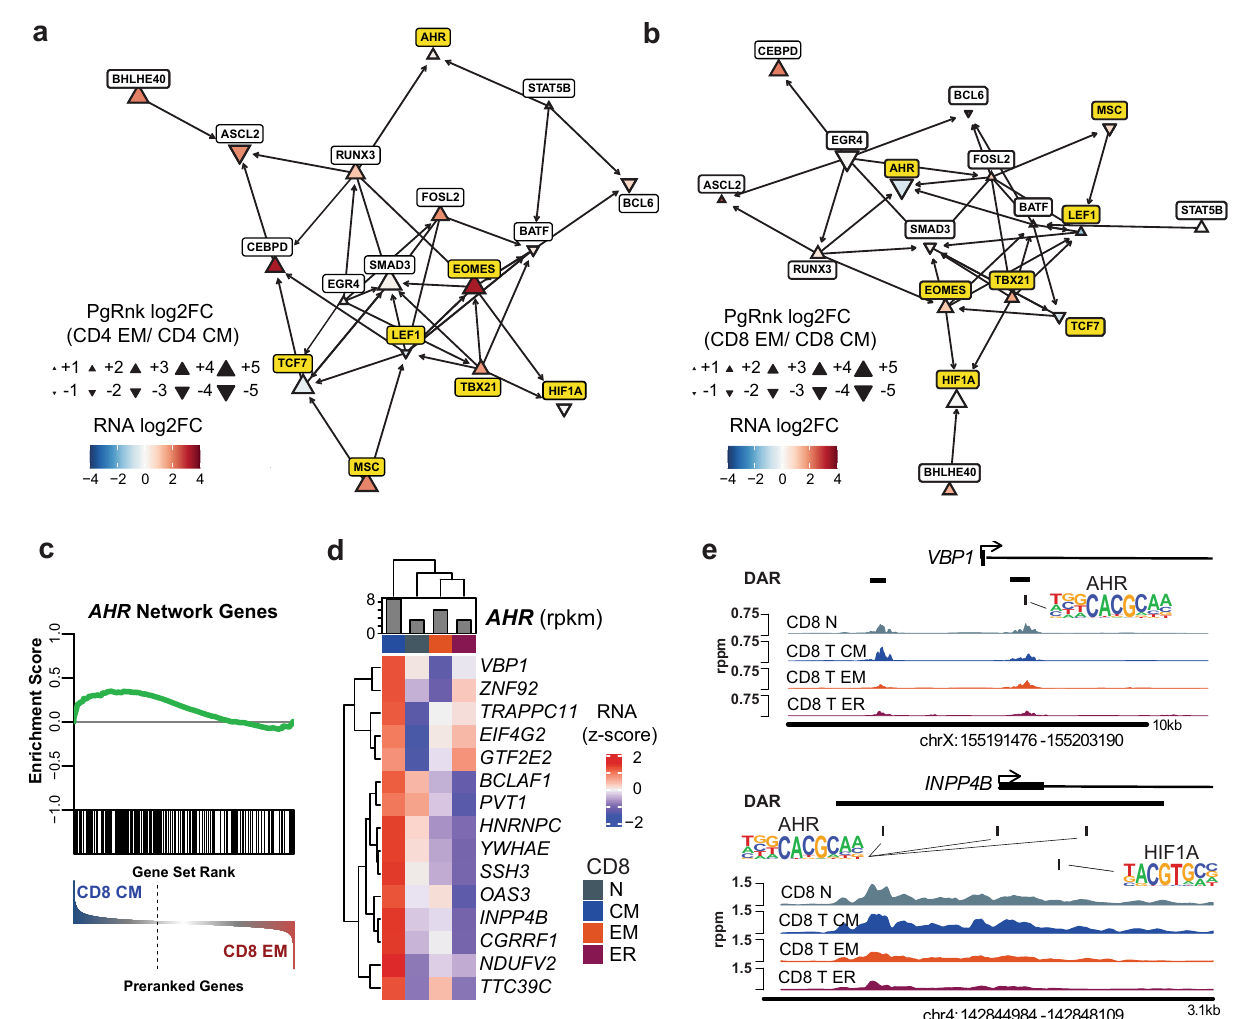
Fig. 6 bHLH transcription factors AHR and HIF1A distinguish CD8 + T CM and T EM . a Network diagram showing transcription factors in CD4 + MTC highly ranked by PageRank and associated connections to other TF. Triangles represent log 2 FC (size) and direction (orientation) of PageRank as indicated in the legend. Arrows represent putative regulation via nearby binding motifs. AHR, HIF1A, MSC, and other memory-subset de fi ning TFs are highlighted in yellow. b Network diagram as in ( a ) for CD8 + T CM and T EM . c GSEA plot using gene set made up of genes putatively regulated by AHR showing enrichment in CD8 + T CM vs. T EM DEG. d Heatmap of leading-edge genes from GSEA most highly upregulated in T CM . Bar plot indicates normalized expression of AHR in rpkm. Data represent the mean expression of each cell subset. e Genome plots showing the average accessibility levels in each of the CD8 + memory and naïve T cells at the indicated locus. DAR are highlighted by black horizontal bars, with AHR and HIF1A binding motifs at indicated locations. Data represent the mean of each cell